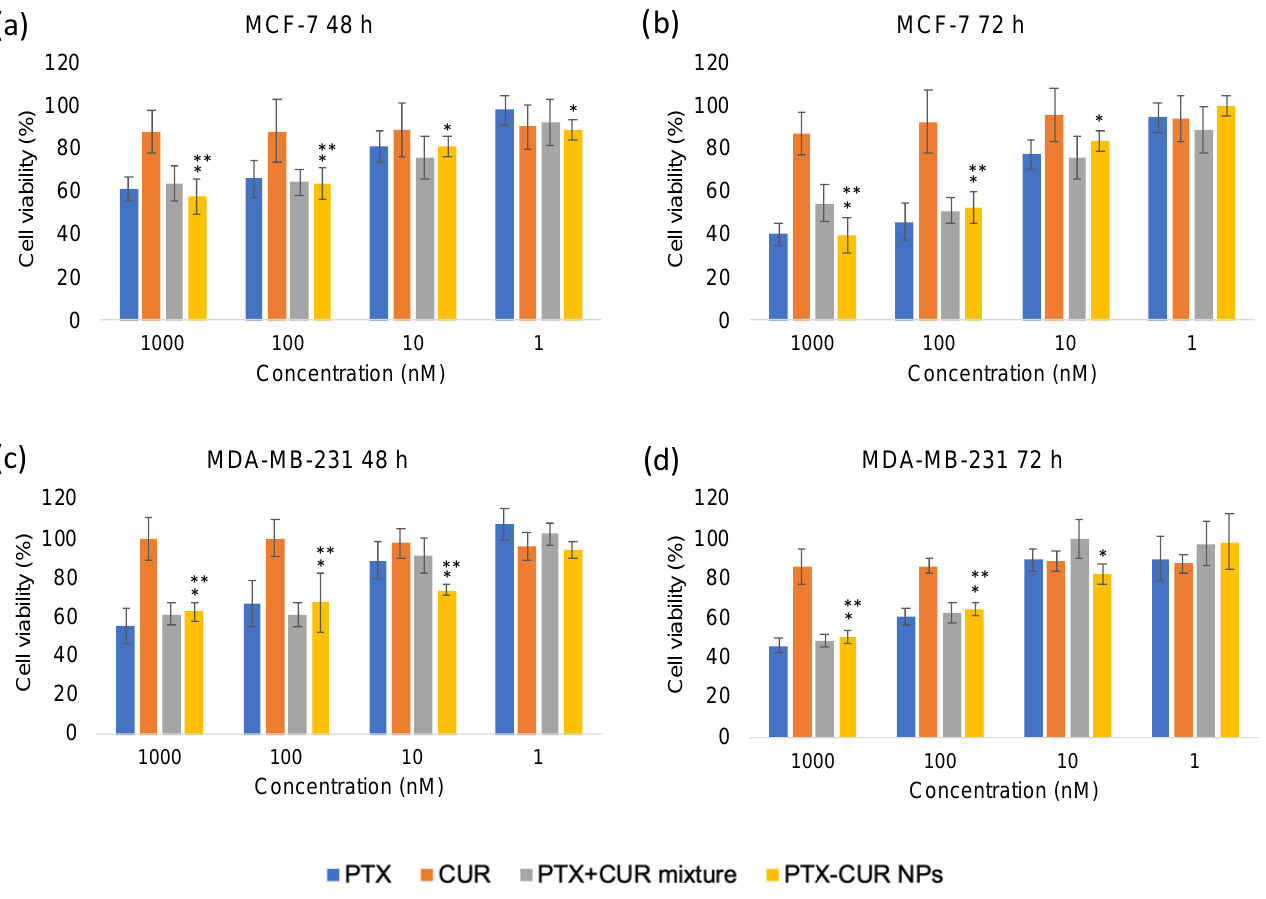
Figure 8. In vitro anticancer activity of PTX, CUR, PTX + CUR mixture, and PTX-CUR NPs in MCF-7 and MDA-MB-231 cells. PTX and CUR stand for paclitaxel and curcumin. Data are presented as means ± SD. * p < 0.05 vs. control. ** p < 0.05 vs. CUR.